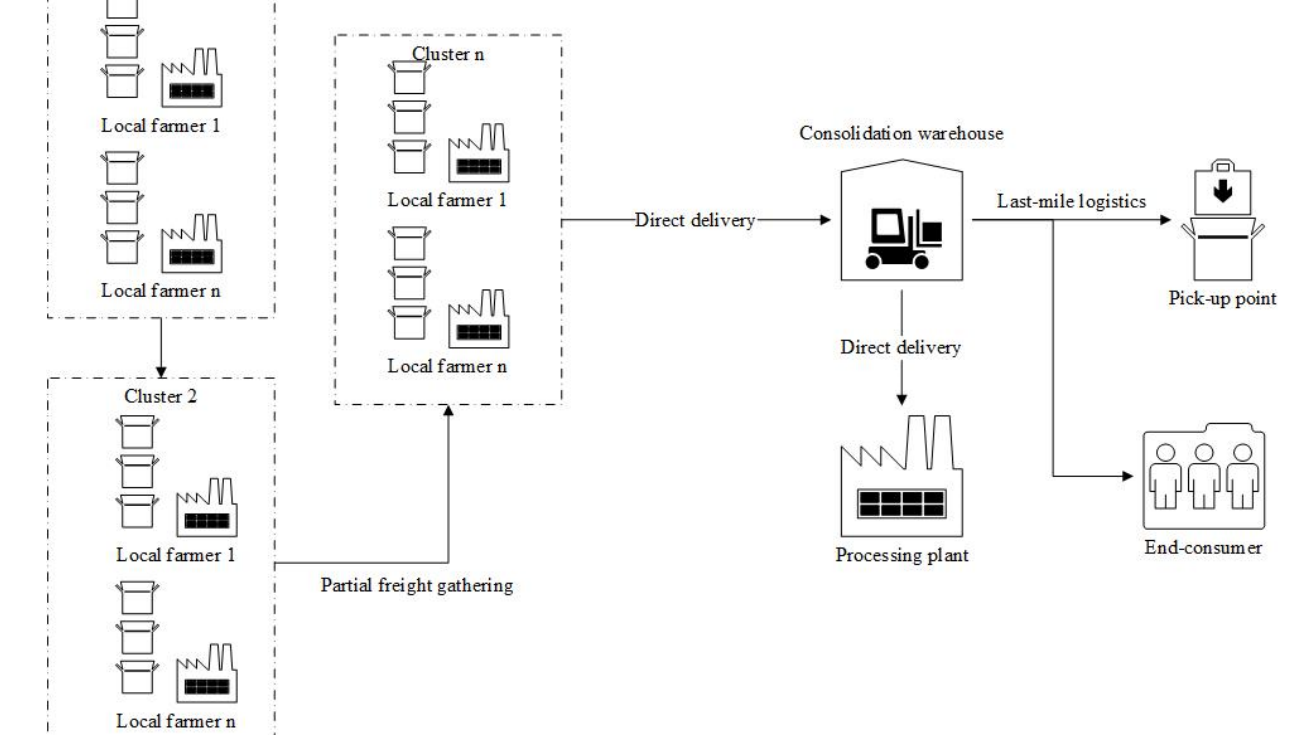
Figure 4. E-commerce adaptation in the food industry for local production, created by authors.